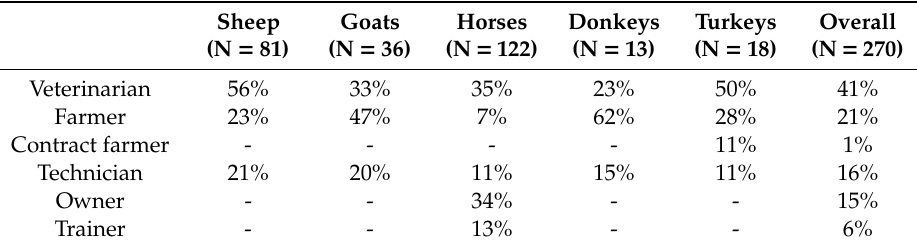
Table 3. Stakeholder roles (%) for each species included in the survey (N = 270).